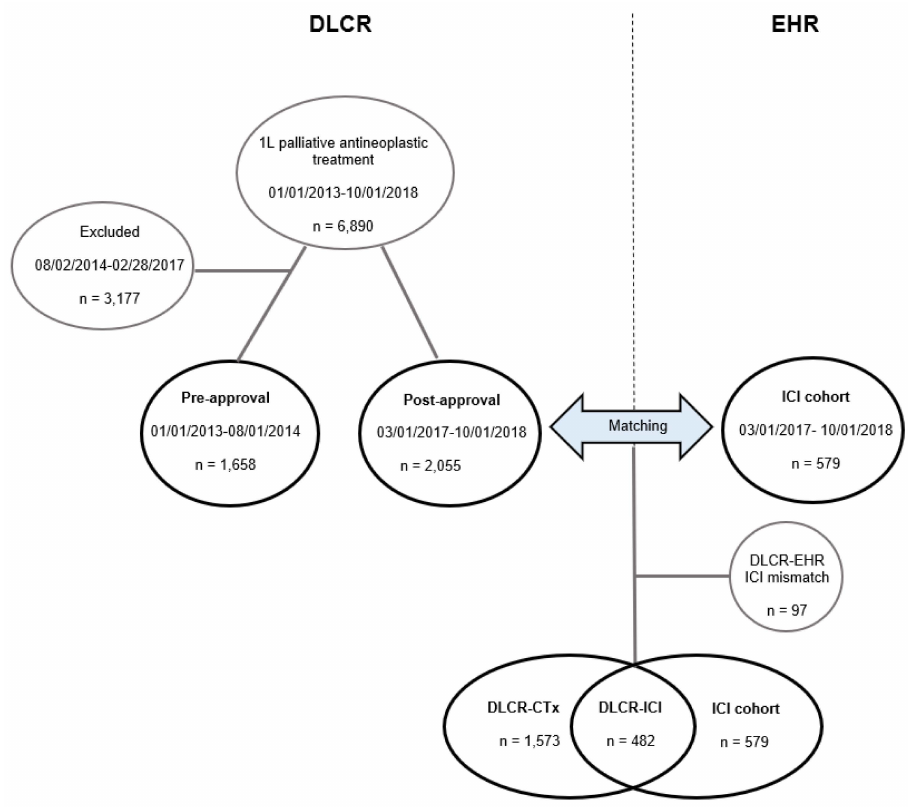
Figure 1. Flowchart showing the generation of the Danish Lung Cancer Registry (DLCR) cohorts before and after the approval of immune checkpoint inhibitors (ICIs). Treatment data from the electronic health records (EHRs) were applied on the DLCR post-approval cohort to divide patients into the DLCR-chemotherapy (CTx) and DLCR-ICI cohorts. Due to missing and inaccurate data in the DLCR, 97 ICI-treated patients identified from institutional records were not registered in the